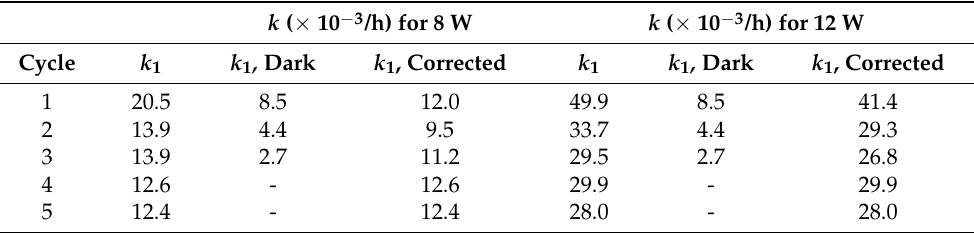
Table 5. Corrected photodegradation kinetics of MB removal under commercial LED bulbs.